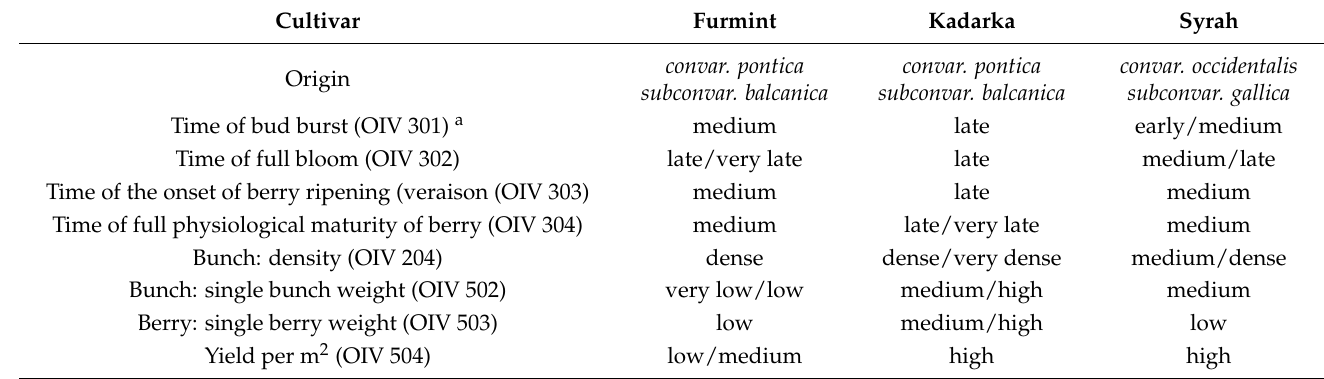
Table 3. Viticultural characteristics of the investigated grapevine varieties [47–49].